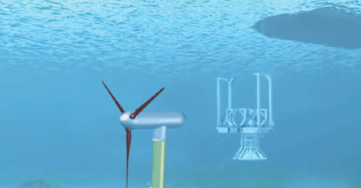
Figure 6. Tool used for manual installation and maintenance maneuvers (installation and recovery of the gondola).